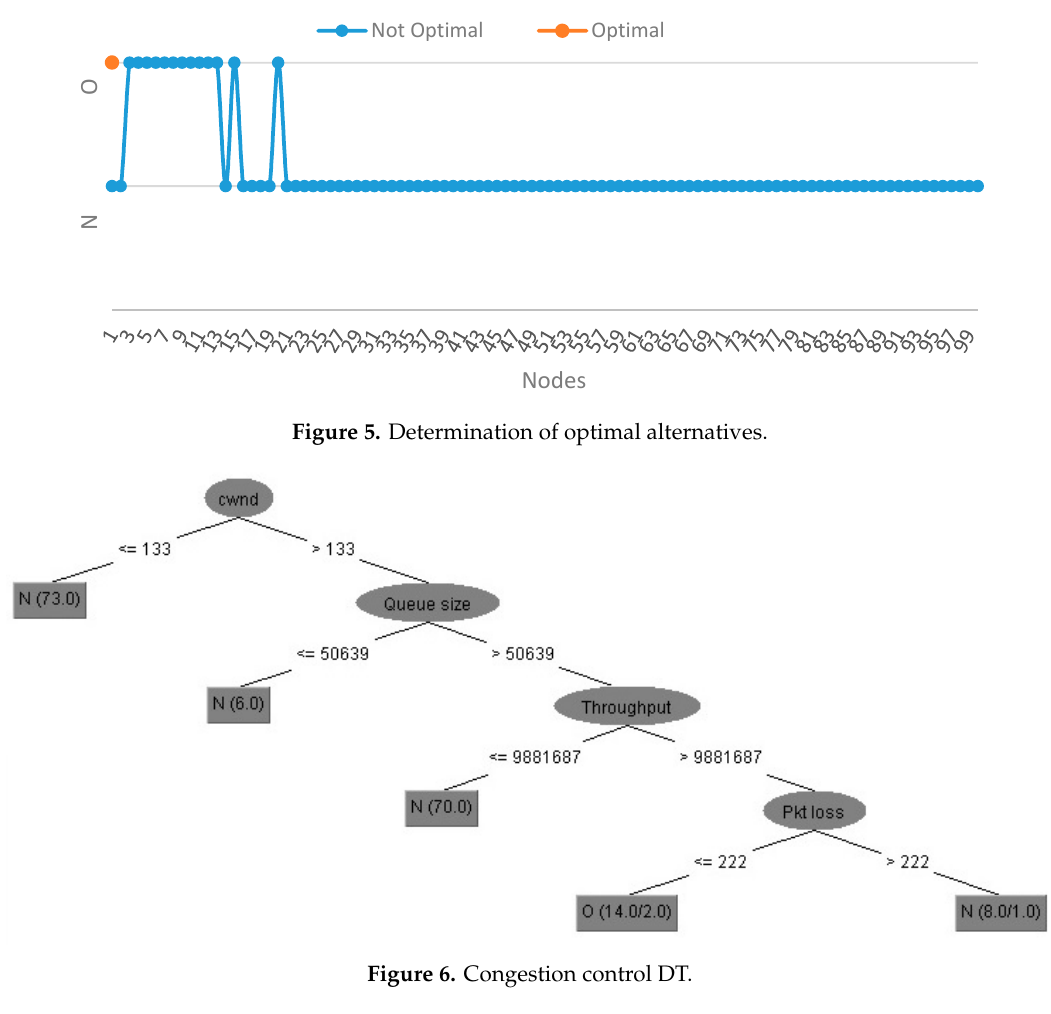
Figure 6. Congestion control DT.